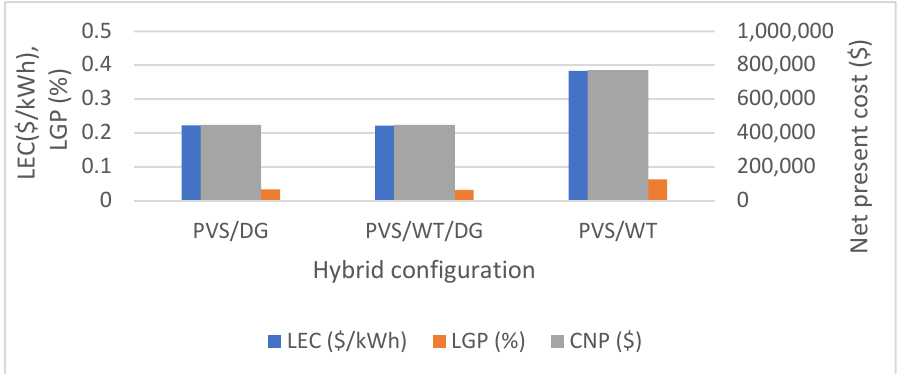
Figure 9. Comparison of TSVA in various hybrid configurations.